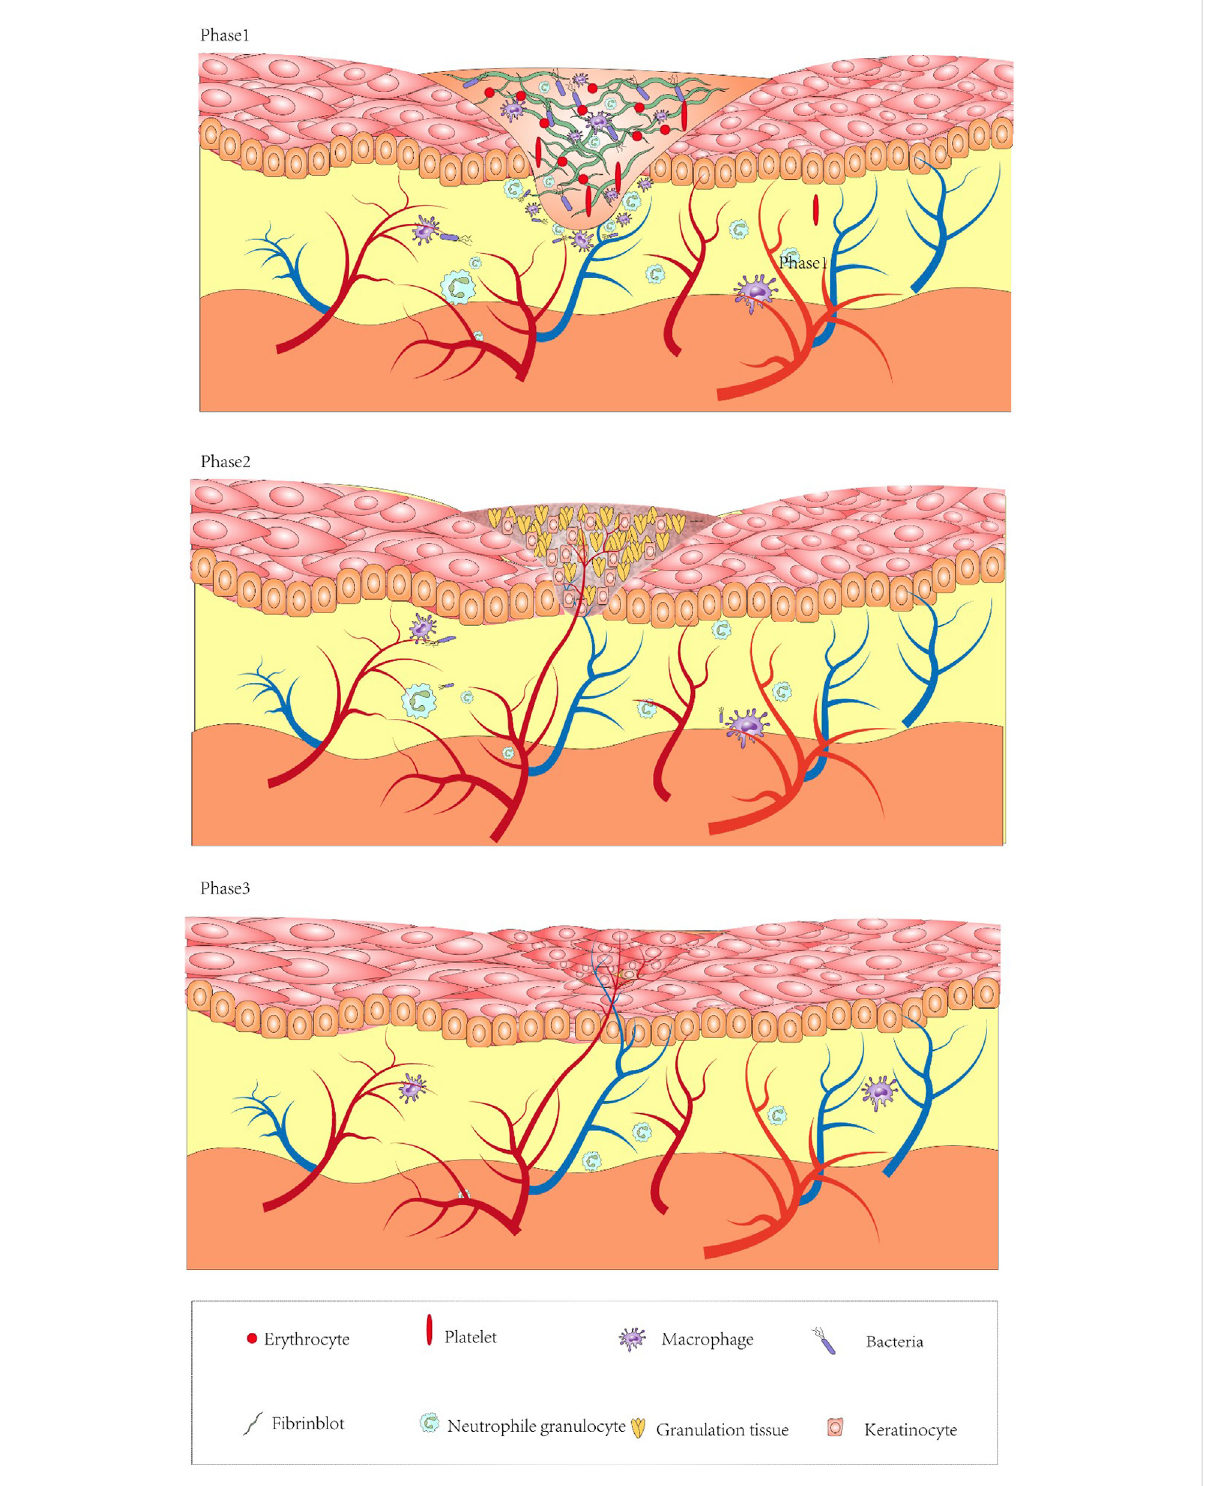
FIGURE 1 Diagram of the mechanisms of wound formation and healing. In fl ammatory phase: after platelets perform initial hemostasis and release chemokinesrecruitingneutrophils, fi broblasts.Conversionofmonocytesintomacrophagesengulfsnecrotictissue,decomposesbacterialproducts, and helps the wound to enter the proliferative phase. Proliferative phase: angiogenesis, granulation tissue regeneration, attachment of fi broblasts onto the wound. Remodeling phase: fi broblasts and myo fi broblasts continuously differentiate to form tight cross